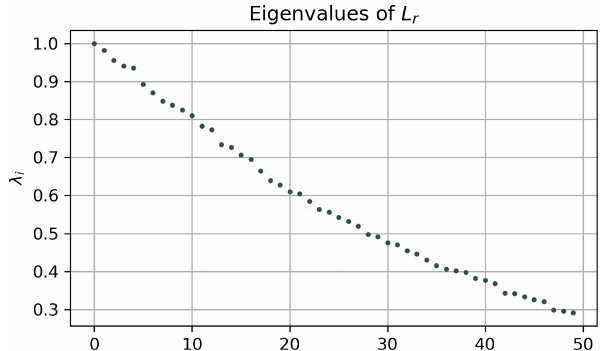
Figure C1. Spectrum of the random walk Laplacian (see Eq. C2) of the network proposed by Padberg-Gehle and Schneide (2017) applied to the Agulhas trajectory data. No clear gap exists to suggest a truncation of the